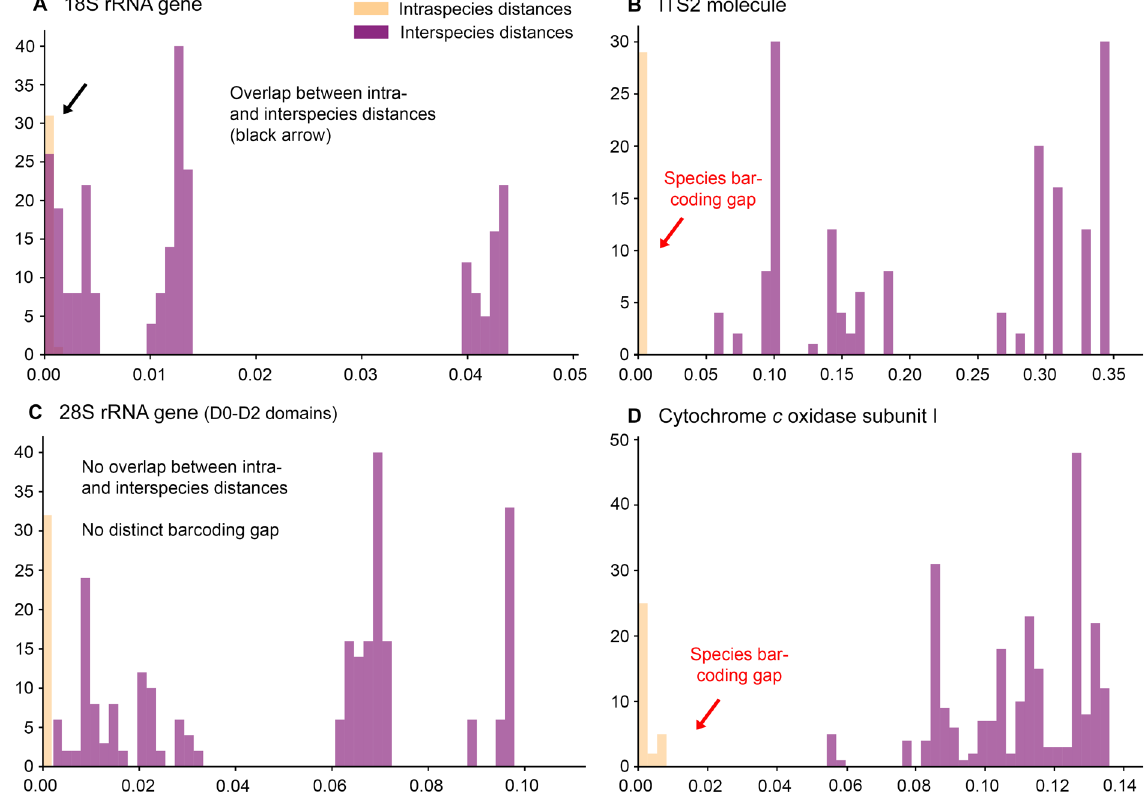
Fig. 4. Histograms showing intra- and interspecies p -distances of four molecular markers studied in nine new gastrotrich species. A . Barcoding analysis of 18S rRNA gene sequences. The black arrow marks the overlap between intra- and interspecies p -distances. B . Barcoding analysis of ITS2 molecules. Sequences are identical within species (red arrow), while interspecies p -distances range from 5.88% to as much as 34.76%. C . Barcoding analysis of the first two domains of 28S rRNA gene. Although there is no overlap between intra- and interspecies p -distances, no distinct barcoding gap is recognizable. D . Barcoding analysis of COI showing the distinct gap between intra- and interspecies p- distances (red